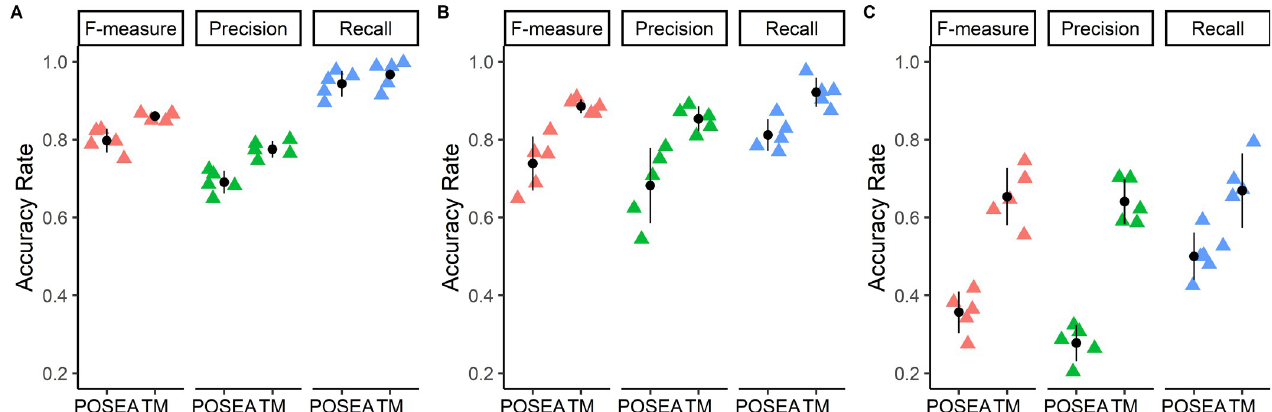
Fig 5. F-measure, Precision, and Recall values calculated by POSEA and the traditional pixel-level method (TM) to compare CellProfiler segmentation results with hand-segmented, ground truth images for quiescent T cells (A), activated T cells (B), and MCF7 cells (C). Each colored triangle is the value for an image (n = 5 images per group). The black circle and lines represent the mean and standard deviation of the 5 data points in each group.